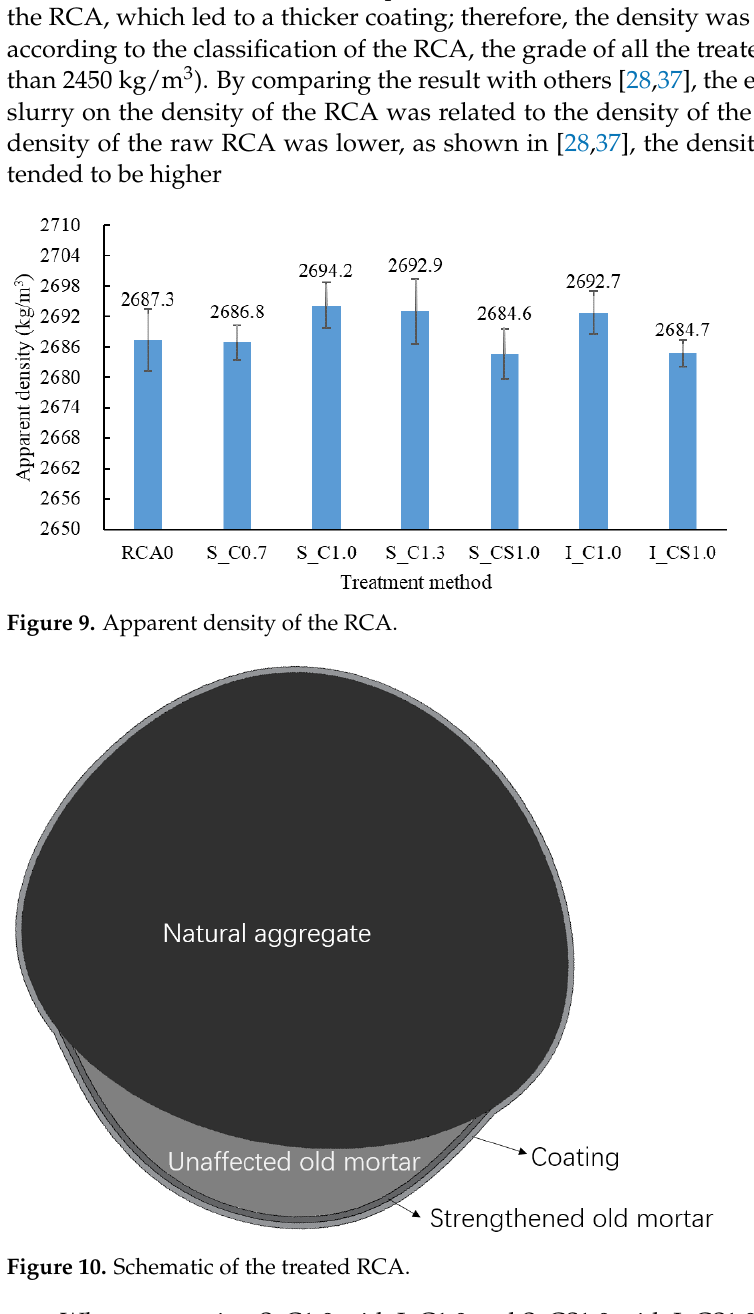
Figure 8. Images of the treated RCA. ( a ) S_C0.7; ( b ) S_C1.0; ( c ) S_C1.3; ( d ) S_CS1.0; ( e ) I_C1.0; ( f ) I_CS1.0.s.